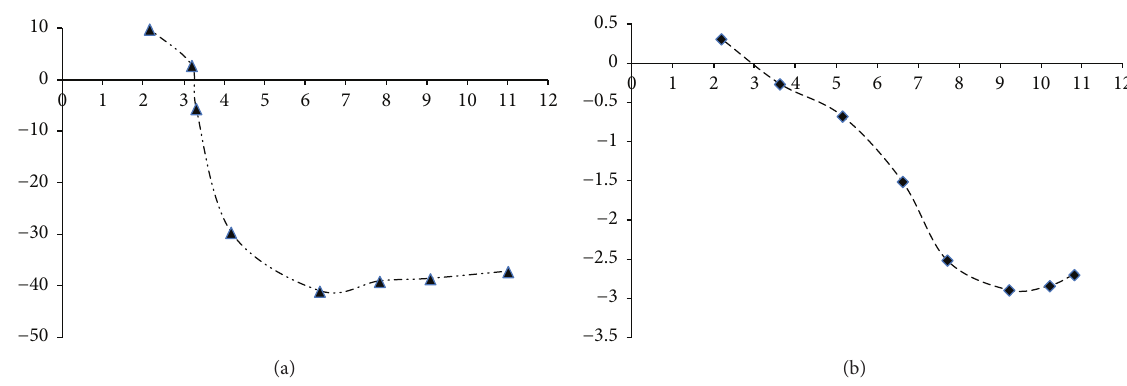
Figure 3: Zeta potential of spectrum of bare pumice (a) and P-nZVI (b).